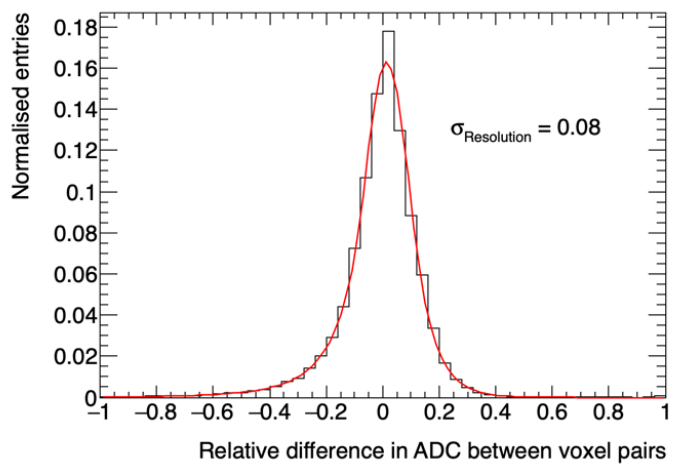
Figure 2. Relative difference in ADC between contiguous voxels calculated using a nearest-neighbor approach. The red line shows a double-sided Crystal Ball fit of the relative differences in ADC throughout the tumor.